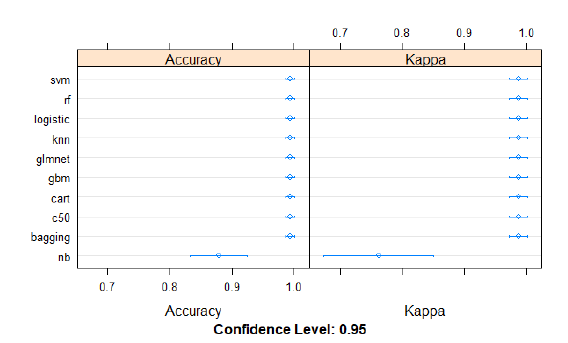
Figure 7. Experiment results for the TPS experimental group.